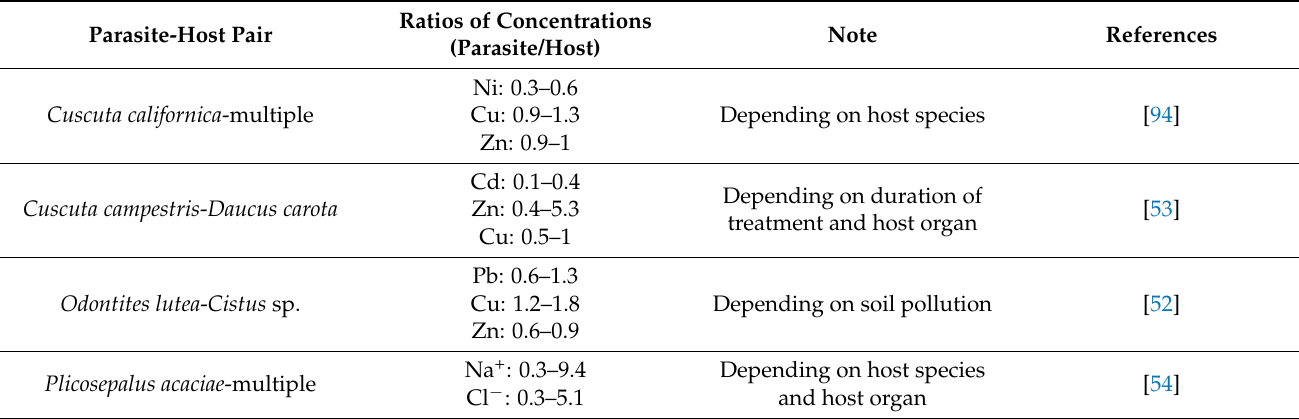
Table 2. Transfer of various elements from hosts to parasitic plants. No simple relationship exists for the proportion of chemical elements found in hosts and parasites: according to the scarce data available in the literature, a certain element in the same parasite can apparently range from less than 10% of the host concentration up to almost 1000-fold, corresponding to a ratio of concentration in the parasite divided by the concentration in the host of 0.1 to almost 10. Ratios of Concentrations Note Parasite-Host Pair (Parasite/Host) Ni: 0.3–0.6 Cuscuta californica -multiple Cu: 0.9–1.3 Depending on host species [94] Zn: 0.9–1 Cd: 0.1–0.4 Depending on duration of Cuscuta campestris - Daucus carota [53] Zn: 0.4–5.3 treatment and host organ Cu: 0.5–1 Odontites lutea - Cistus sp. Na + :